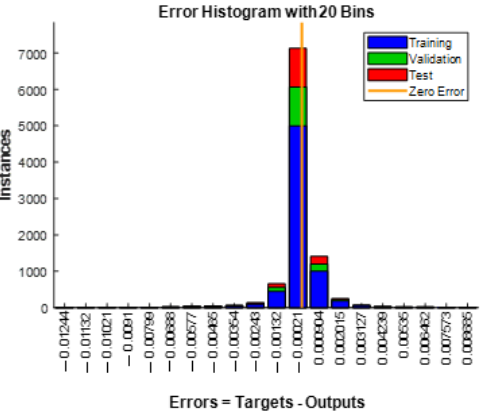
Figure 6. Error Histogram 10 neurons after 100 epochs .